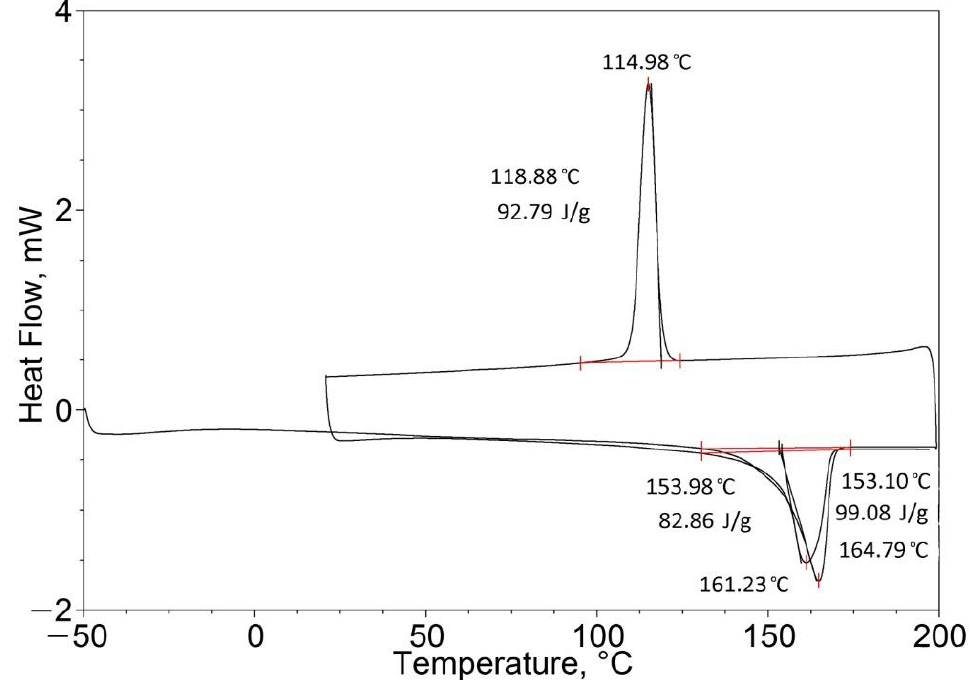
Figure 8. Melting-crystallization-melting diagram (DSC scan curves) of the PP polymer sample obtained by SEDS.